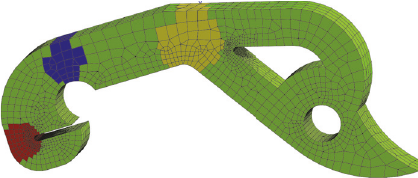
Figure 3: The red, blue, and yellow regions have been submitted to variations of the Young modulus in order to enhance the space spanned by the simulation data. The region in red is the region of interestselectedby thedesigner of the experimentalsetup.The mesh shown here is the mesh G 4 . It has 5. 10 5 degrees of